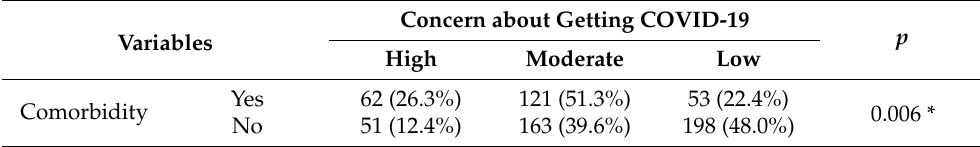
Table 8. Association between concern about the spread of COVID-19 and the comorbidity of participants.